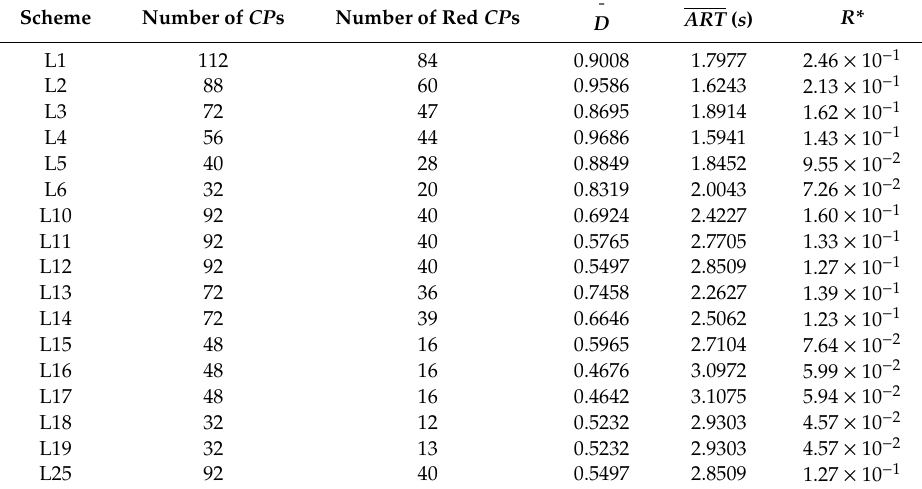
Table 4. Results of the risk analyses—focus on